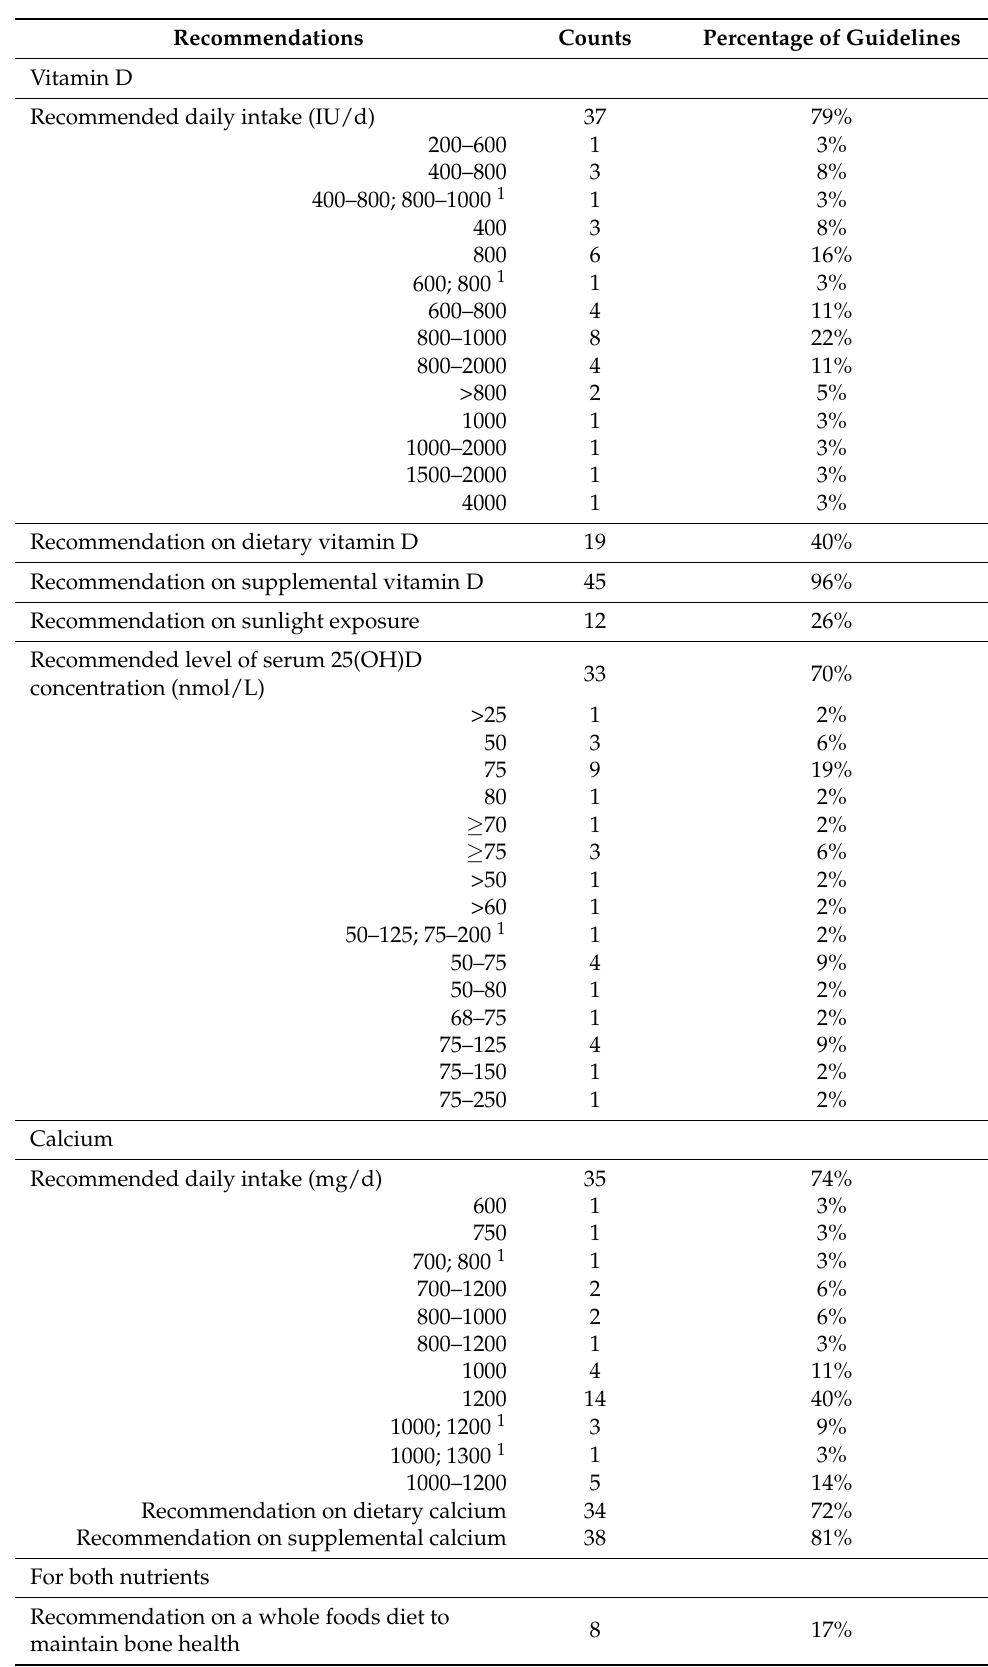
Table 3. Percentage of guidelines presenting recommendations on vitamin D and calcium ( n =